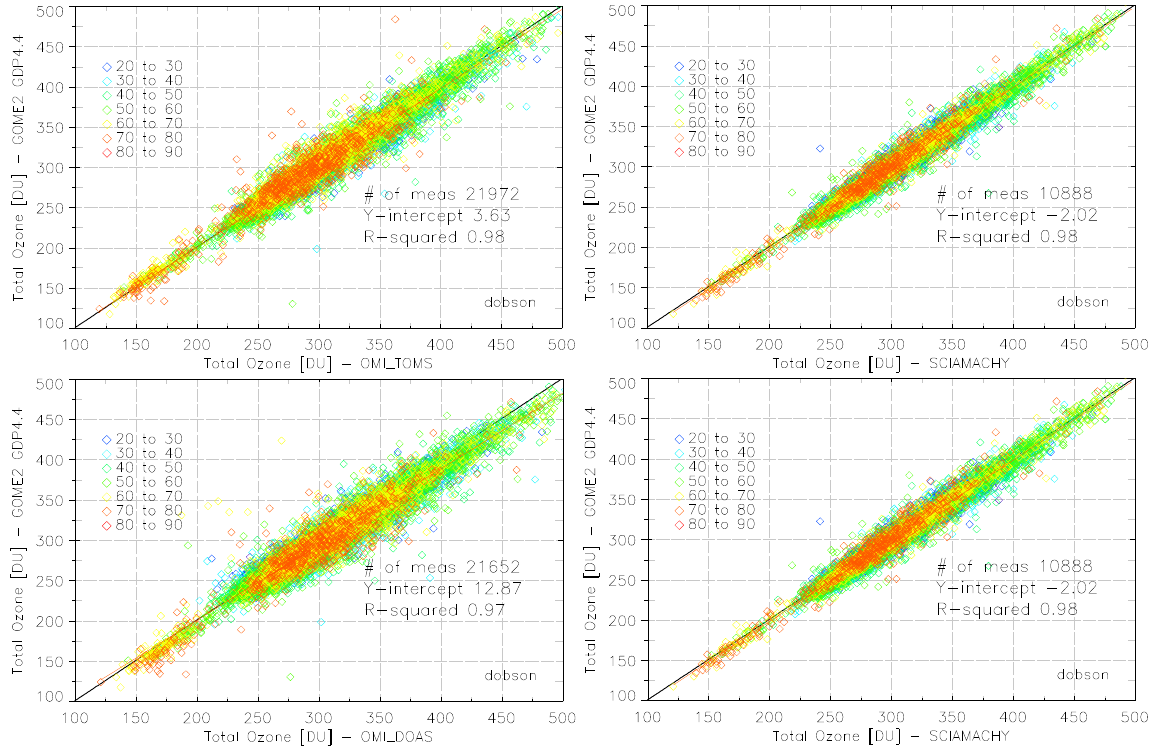
Fig. 5. Direct scatter plot comparisons of the satellite total column at the overpass sites for the Dobson ground-based stations. Top row: GOME-2 (on the y-axis) to GOME (left plot) and OMI TOMS (right plot). Bottom row: GOME-2 (on the y-axis) to OMI DOAS (left plot) and SCIAMACHY (right plot). The points are colour-coded according to the SZA related to that measurement. The r-squared and y-intercept of the scatter line (red) are also